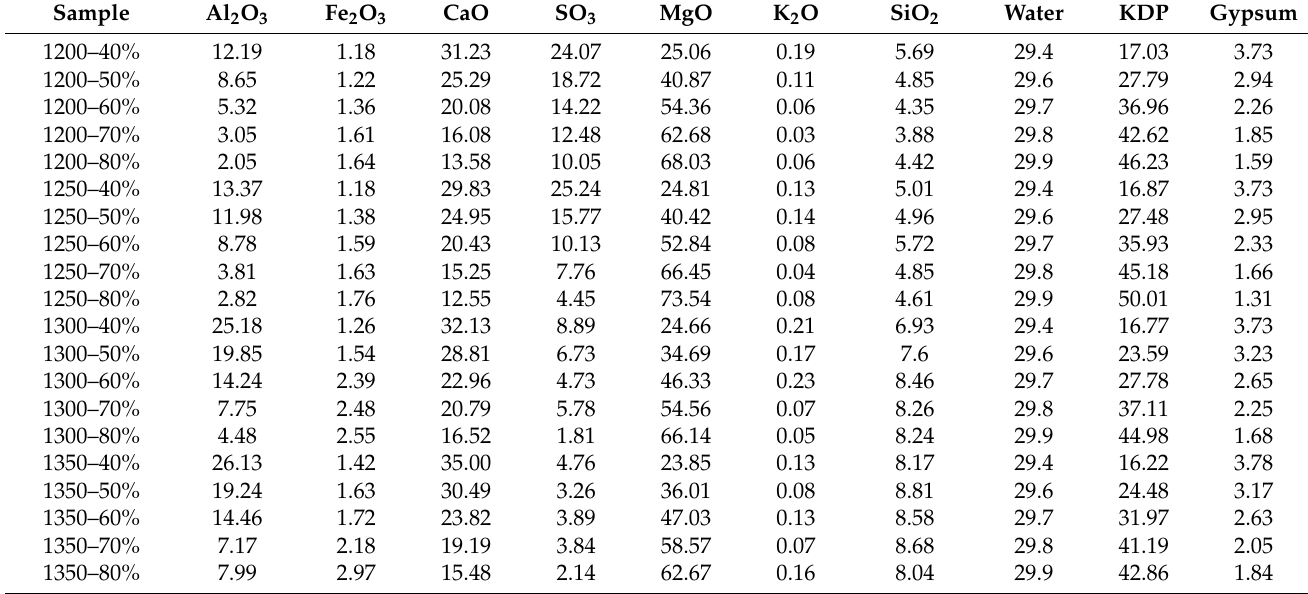
Table 4. Mix proportions for the secondary mixing (g/100 g